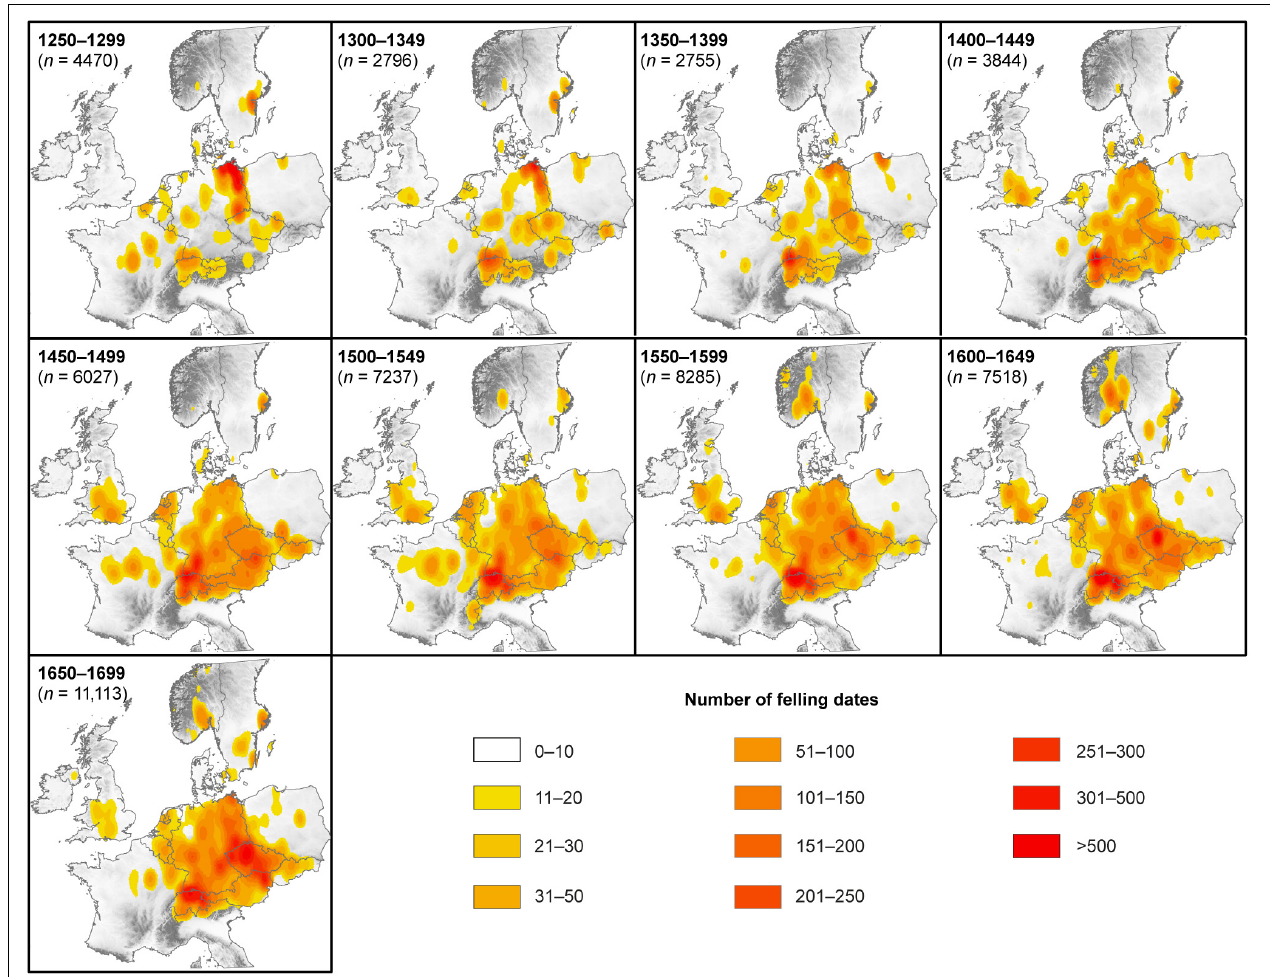
FIGURE 4 | Heat-maps of the number of felling dates for each 50-year period covered by our dataset. The maps are shown with contemporary political boundaries.